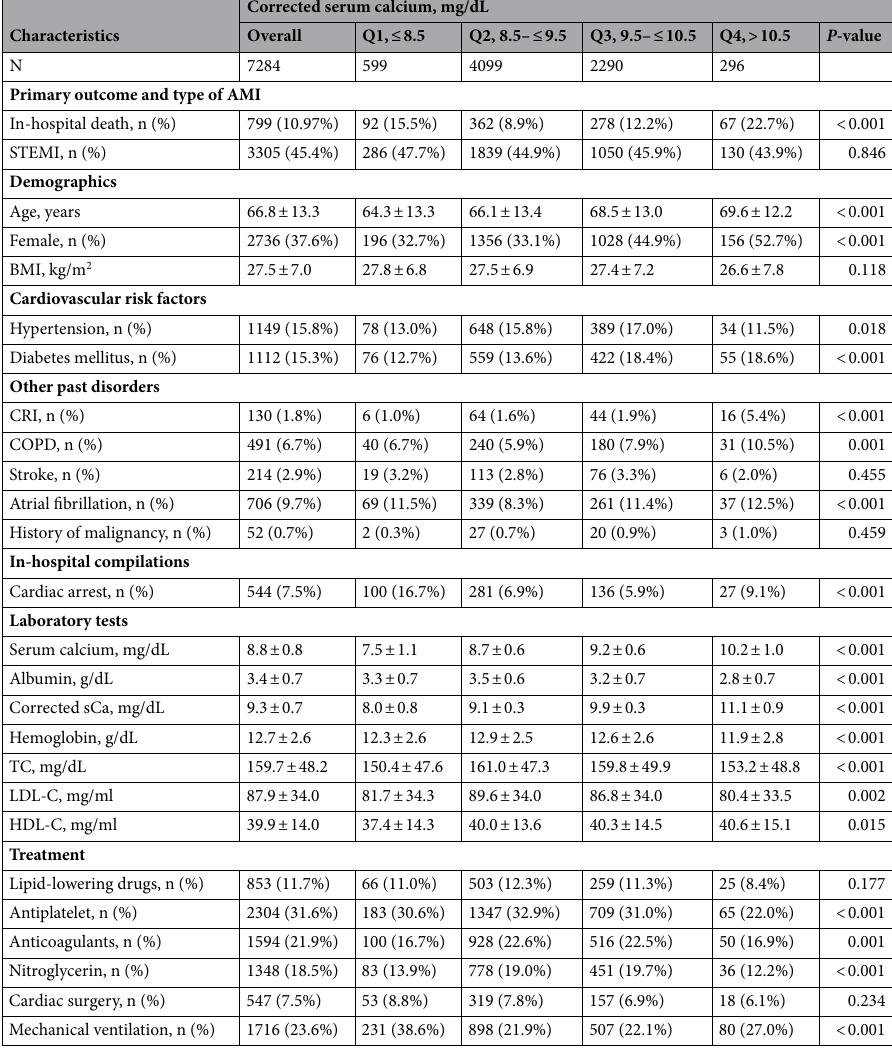
Table 1. Characteristics of study patients. STEMI, ST-segment elevation myocardial infarction; BMI, body mass index; CRI, chronic renal insufficiency; COPD, chronic obstructive pulmonary disease; Corrected sCa, corrected serum calcium; TC, total cholesterol; LDL-C, low-density lipoprotein cholesterol; HDL-C, high- density lipoprotein